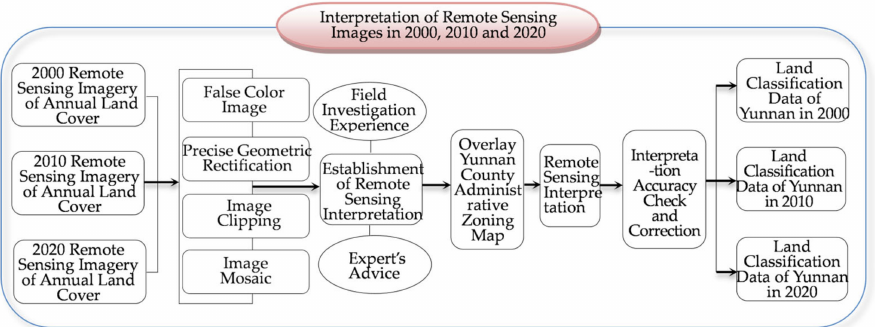
Figure 2. Remote sensing Image Interpretation in 2000, 2010, and 2020 in Yunnan Province.